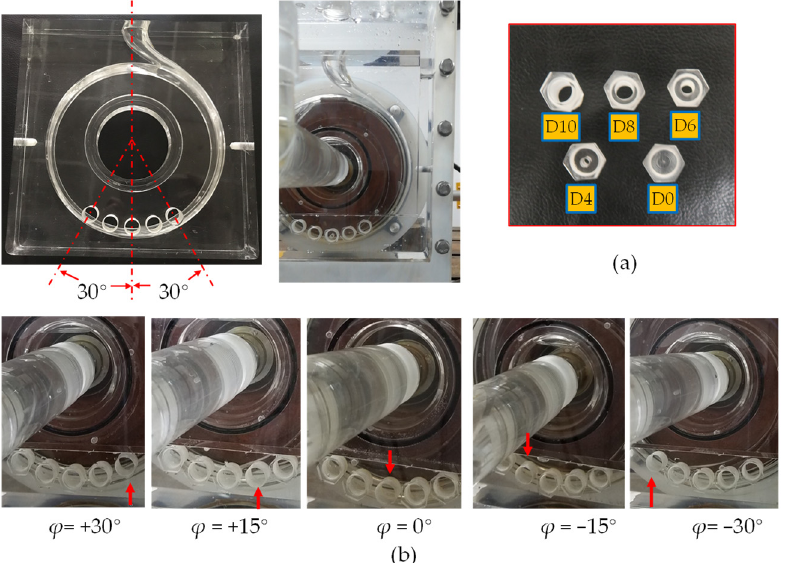
Figure 2. Reflux hole design details. ( a ) Reflux hole plug with different diameters; ( b ) Reflux hole with different position.